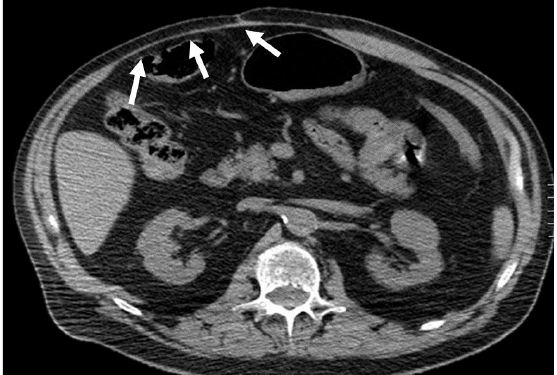
Diagnostics 2022 , 12 , x FOR PEER REVIEW Figure 6. Axial, not-enhanced CT scan shows the congenital absence of the right rectus muscle (arrows). Neuromuscular dystrophies can also present defects of the abdominal wall. Du- chenne muscular dystrophy is the most common one and is clinically characterized by progressive muscle weakness, starting from the proximal pelvic girdle [22], whose path- ognomonic appearance on CT and MR is a progressively extensive fatty replacement of muscles [22,23] (Figure 7).